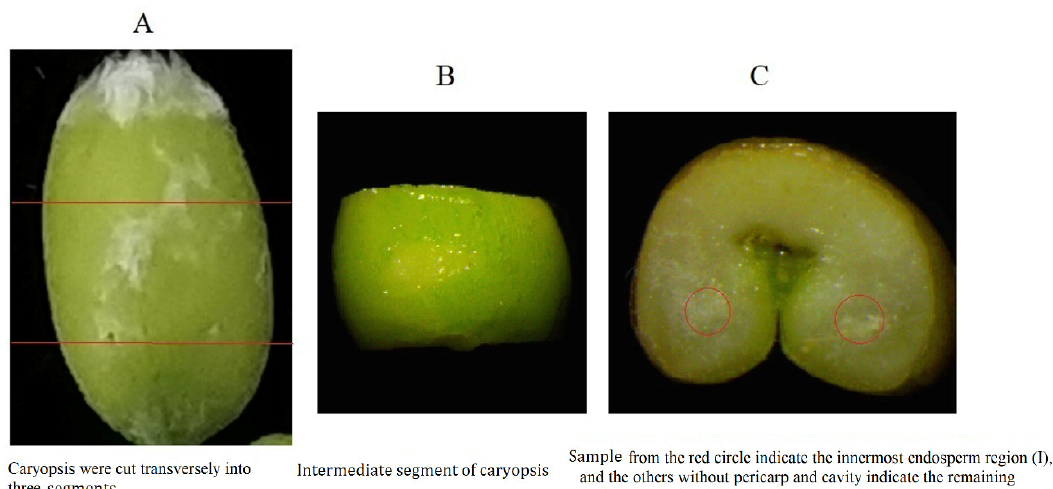
Figure 8. Division of different regions of wheat grain endosperm. ( A ) The red line indicate the transection location. ( B ) The intermediate segment of caryopsis is divided into the innermost endosperm region and the remaining endosperm region. ( C ) The red circle indicated the innermost endosperm region.